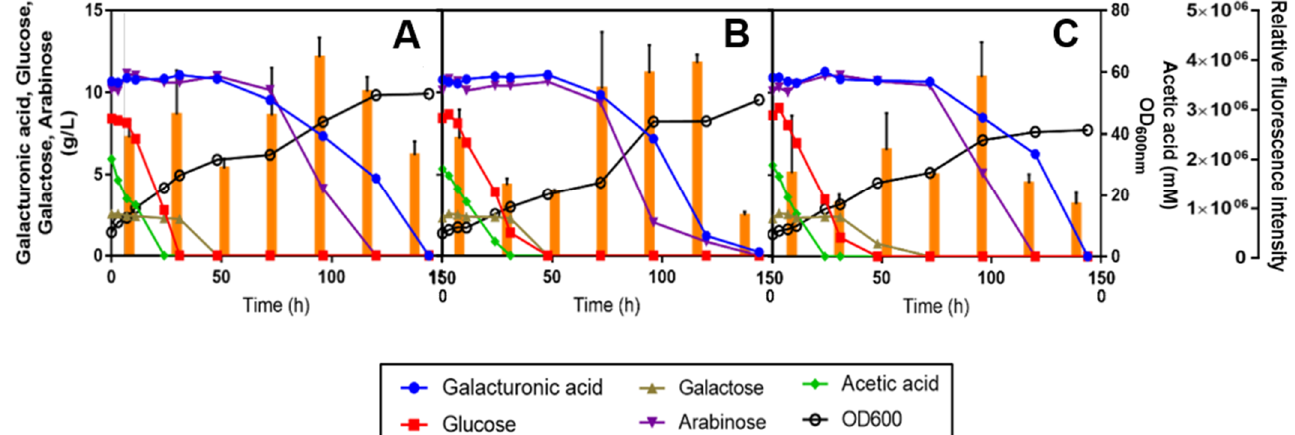
Figure 7. Bioconversion of SBP hydrolysate H13 supplemented with 1.7 g/L of YNB (without ammonium sulphate or amino acids) and with 2.5 g/L ammonium sulphate and the amino acids present in commercial YNB, at pH 5.0, by R. mucilaginosa IST 390 ( A ), R. toruloides PYCC 5615 ( B ) and R. toruloides IFO 0880 ( C ) for lipid production. Cultivations were performed at 30 °C, with orbital incubation (250 rpm). Media were inoculated with cells corresponding to an initial optical density of 8. Lipid production was assessed by Nile Red staining with a normalized cell suspension (OD 600 nm = 1) and based on relative fluorescence units (RFU). Orange bars represent average RFU values and standard deviation values are shown.